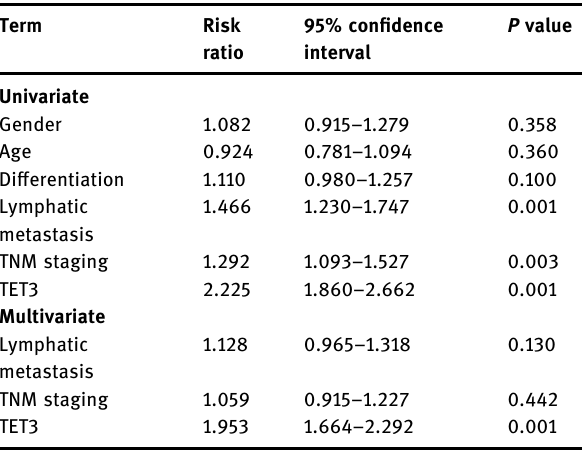
Table 2: Univariate and multivariate Cox ’ s proportional hazard models ( n = 62